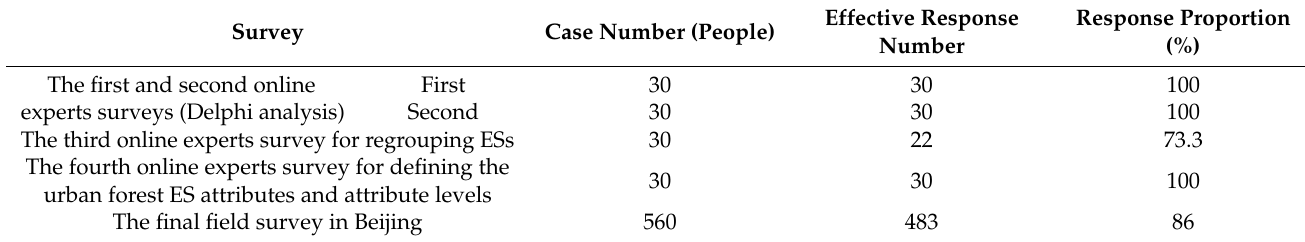
Table 8. Response